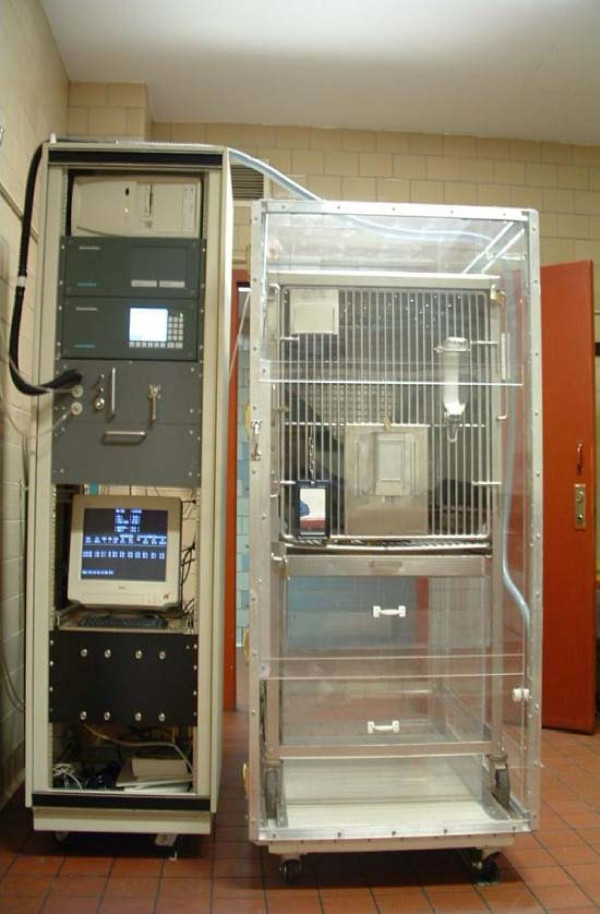
Monkey EMTAC showing the instrument rack to the left side of the Plexiglass enclosure. The Plexiglass enclosure is shown with the monkey metabolic cage and phantoms inside.